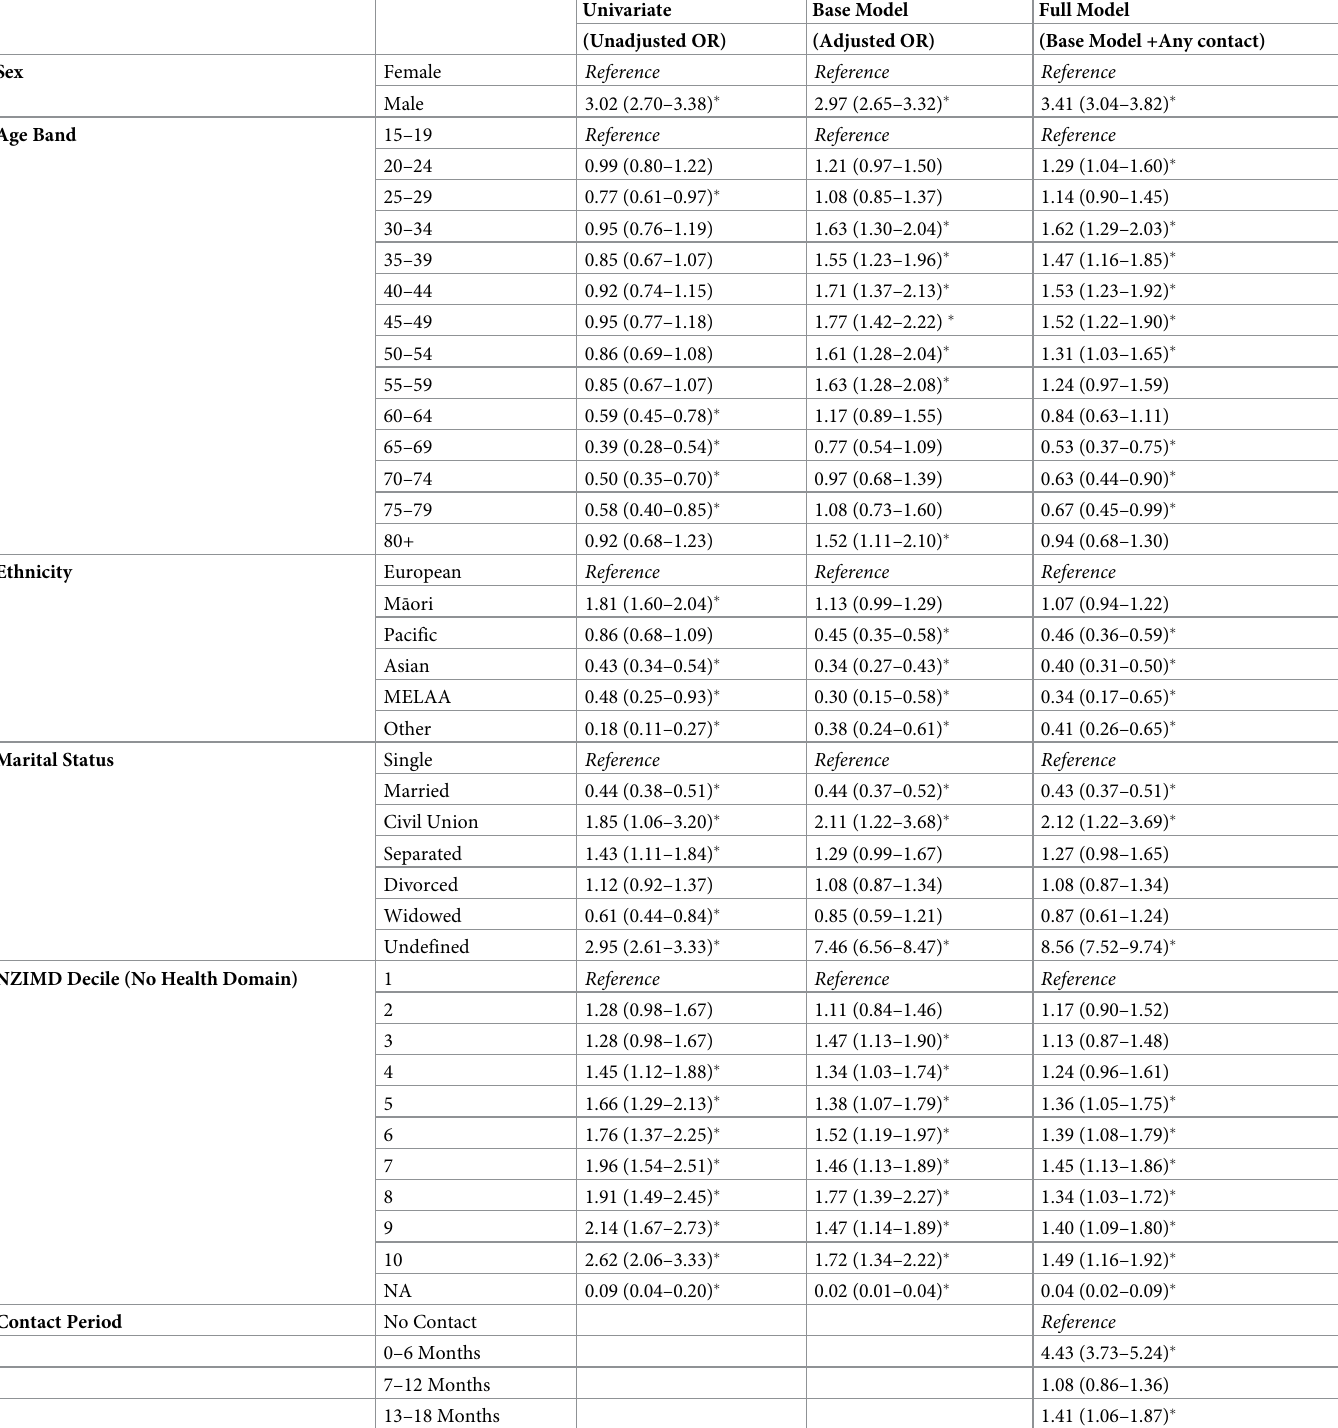
Table 2. Univariate and adjusted odds ratios for base model and full